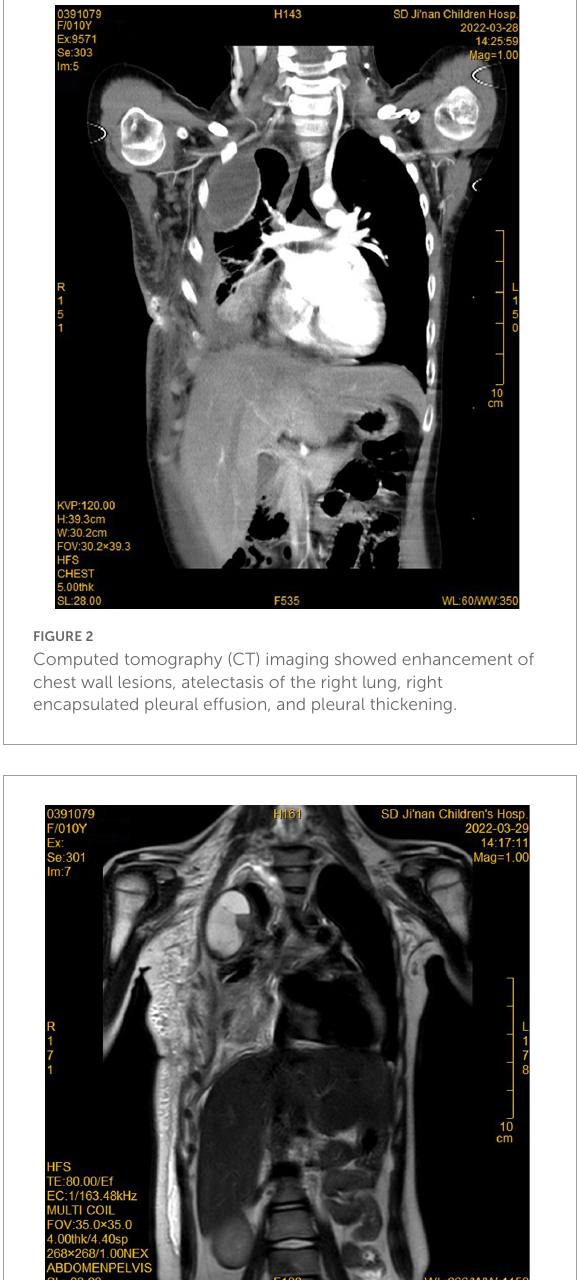
FIGURE3 Magnetic resonance imaging (MRI) showed enhancement of chest wall lesions, atelectasis of the right lung, right encapsulated pleural effusion, and pleural thickening.